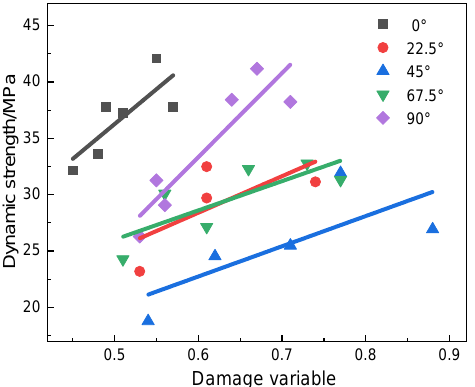
Figure 10. The relationship curve between dynamic strength and damage